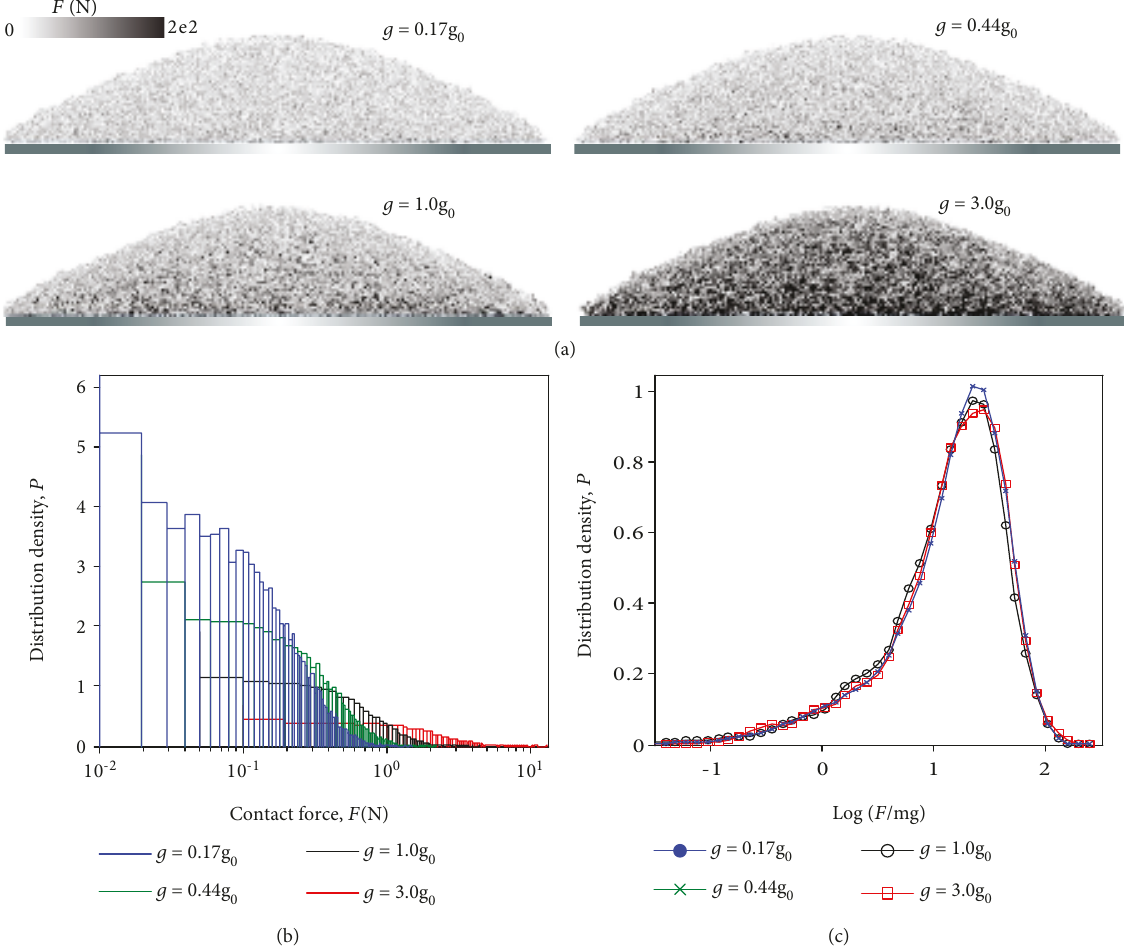
Figure 5: Contact force within particulate piles formed under di ff erent kinds of gravity accelerations for sample S networks, (b) distribution function of contact forces, and (c) distribution function of normalized contact